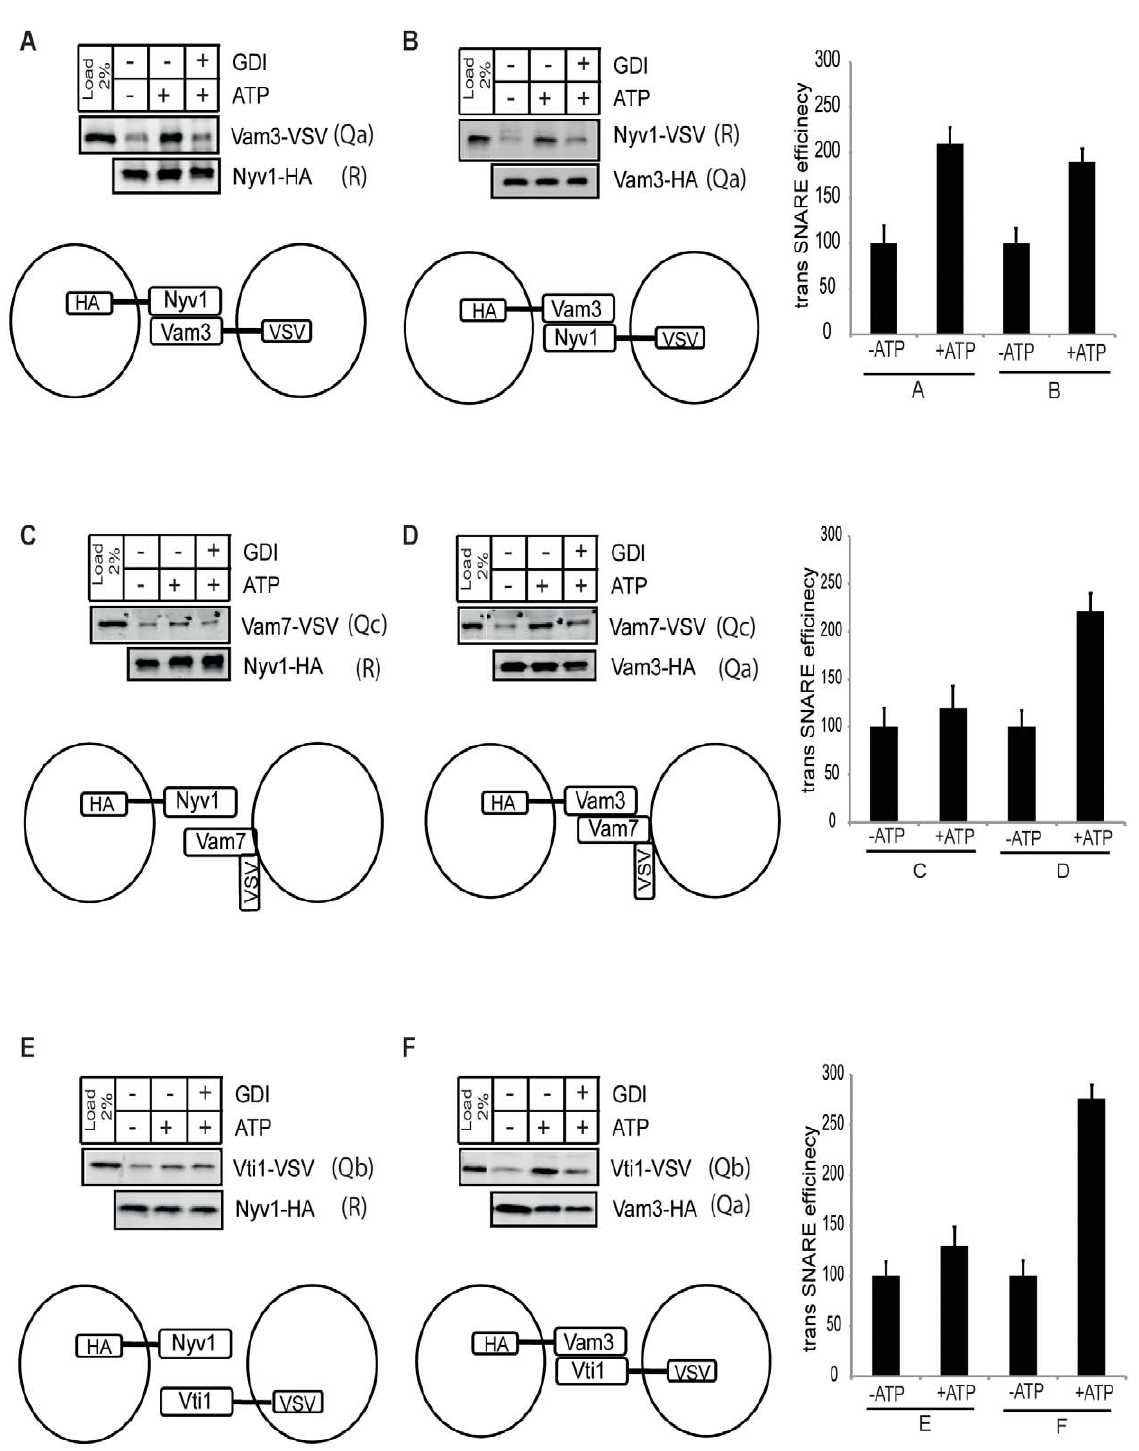
Figure 1. trans -SNARE complexes assayed by tagged SNAREs. Vacuoles were prepared from BJ3505 strains carrying individual SNAREs tagged with (HA) 3 or VSV peptide epitopes at their C-termini. Vacuoles were incubated under standard fusion conditions in the presence or absence of ATP or in the presence of ATP and GDI. Trans -SNARE assay was performed as described under ‘‘Material and Methods.’’ After 30 min at 7 u C, vacuoles were solubilized and immunoprecipitated with antibodies to the (HA) 3 tag. Precipitated proteins were analyzed by SDS-PAGE and Western blotting against the indicated proteins. The 2 ATP value was set to 100%. The percentages of the + ATP and + ATP/GDI values were calculated. The quantification of protein band in Western blot was done by Odyssey densitometry. Three independent experiments are shown as means + / 2 SD.